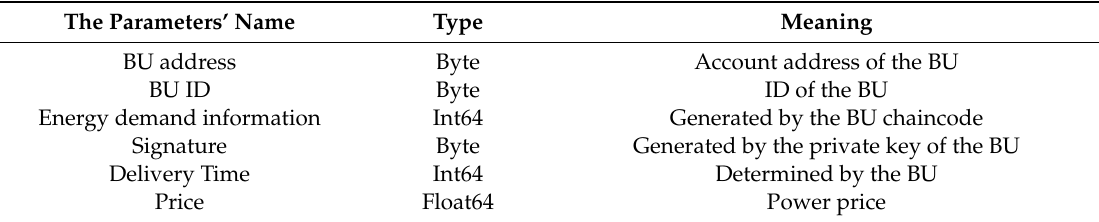
Table 3. Basic elements of the BU